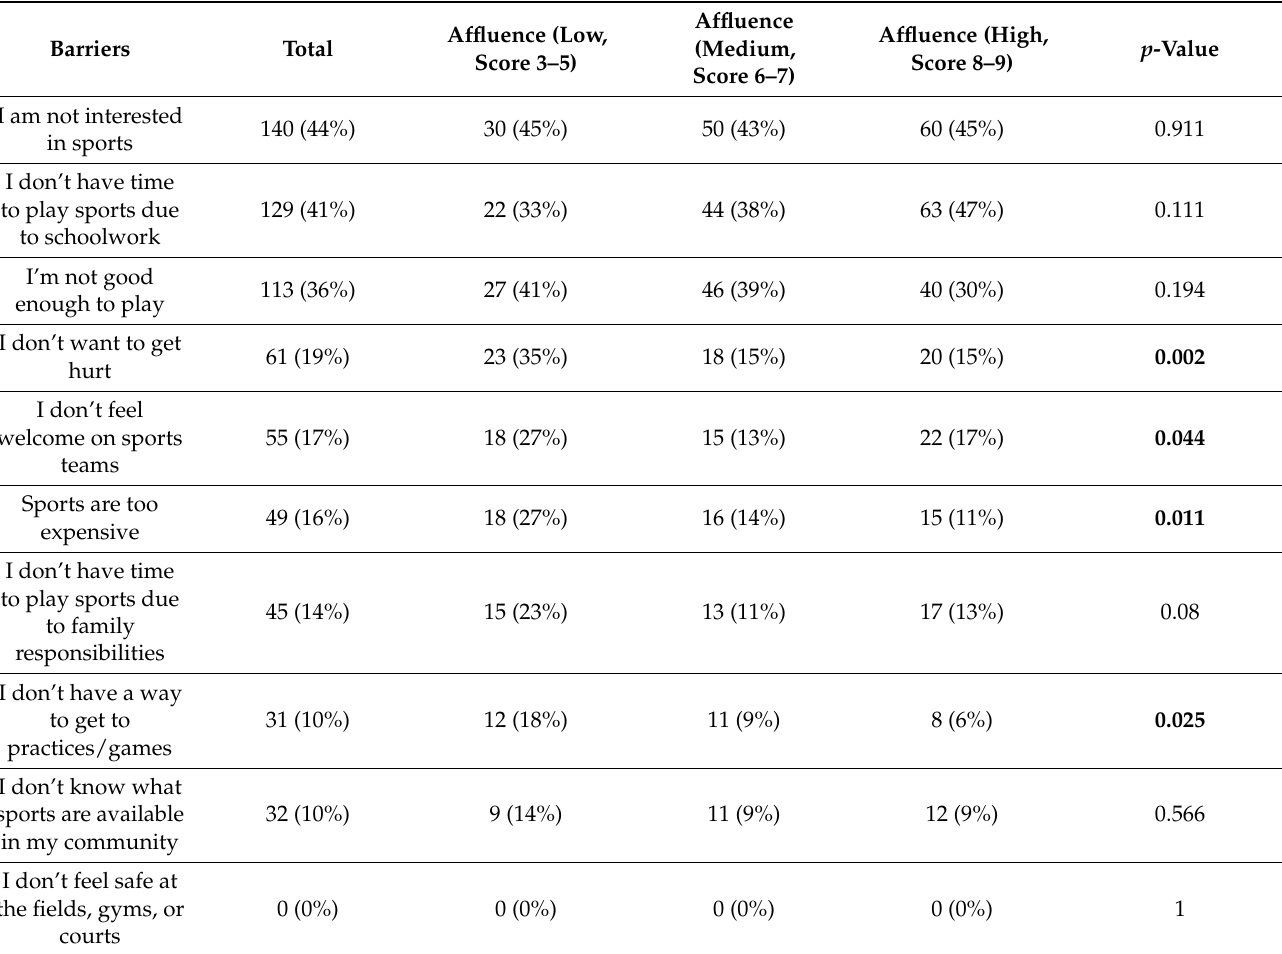
Table 3. Barriers to sports participation (among those who do not currently participate in organized sport) by family affluence ( n =